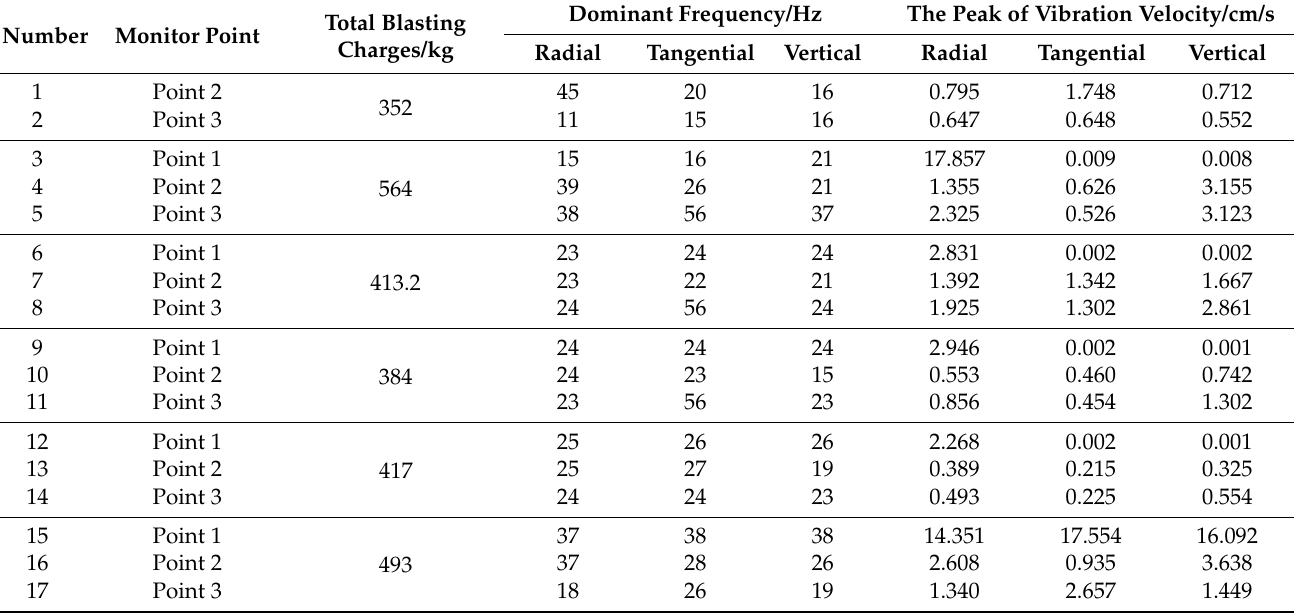
Table 8. Monitoring data of blasting